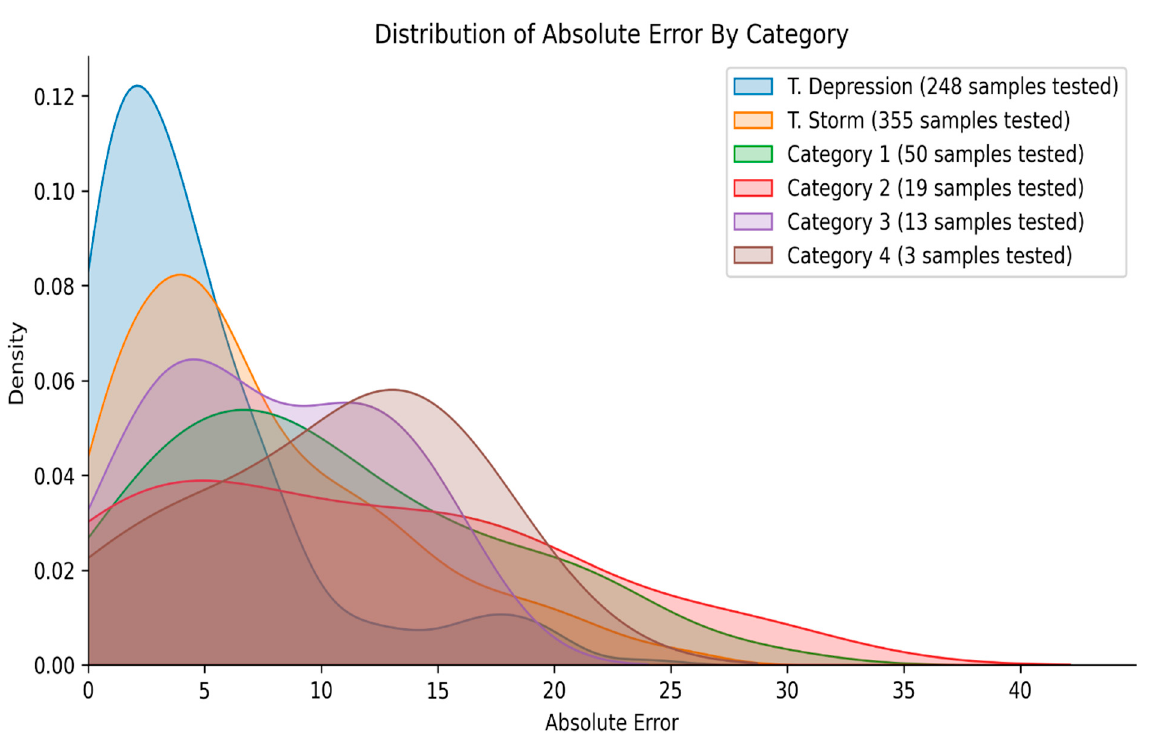
Figure 12. Absolute errors of different hurricane categories.